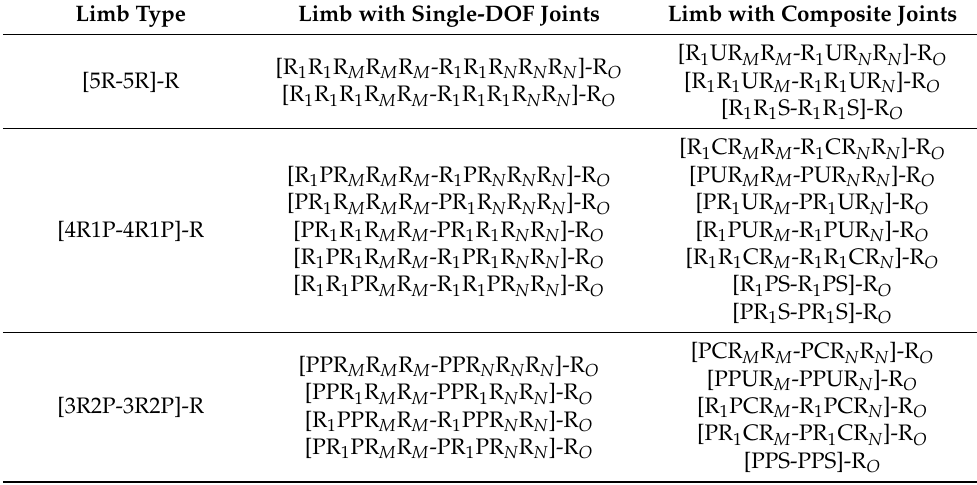
Table 2. The second class of F-hybrid limbs. Limb Type Limb with Single-DOF Joints